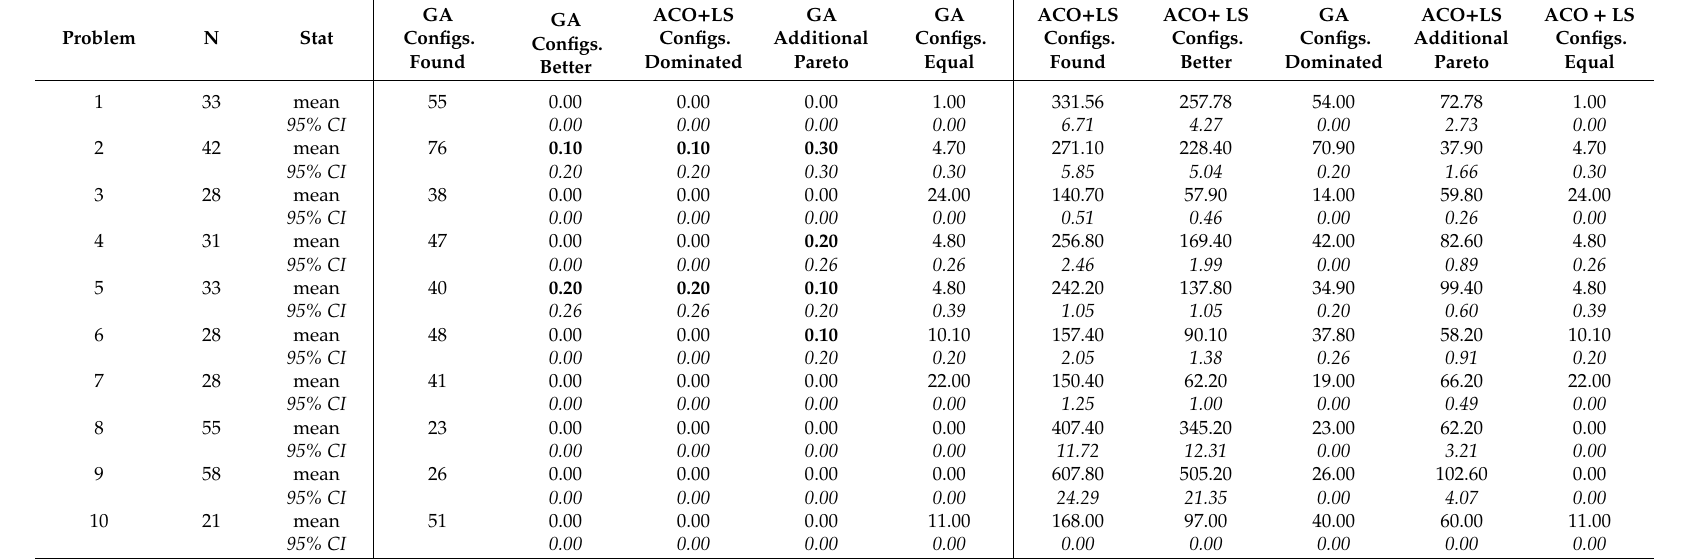
Table 2. Comparison of ACO + LS 10-min runs with GA Benchmark runs. Results of 10-minute ACO + LS runs, each repeated ten times for each problem, versus GA benchmark solutions. In the first part of the table, GA configurations are compared to ACO + LS, while in the second, vice-versa. The means are computed over the ten runs, and values in italics indicate the 95% confidence interval (CI) of the estimate of the mean. Boldface is used to indicate when GA has better or additional solutions than those found by ACO +